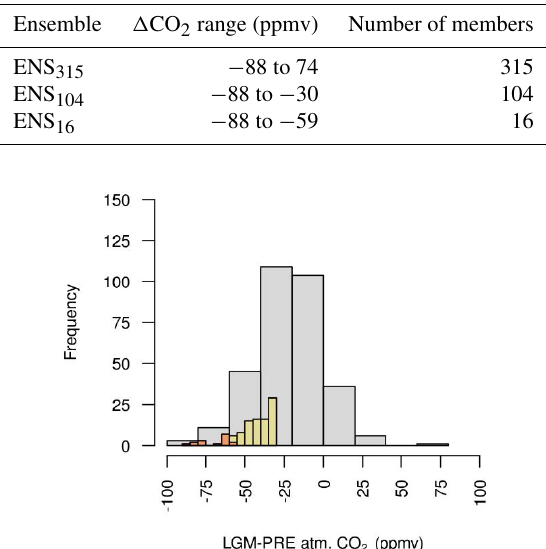
Table 2. Ensemble subsets, including (cid:49) CO 2 and number of mem- bers in each.